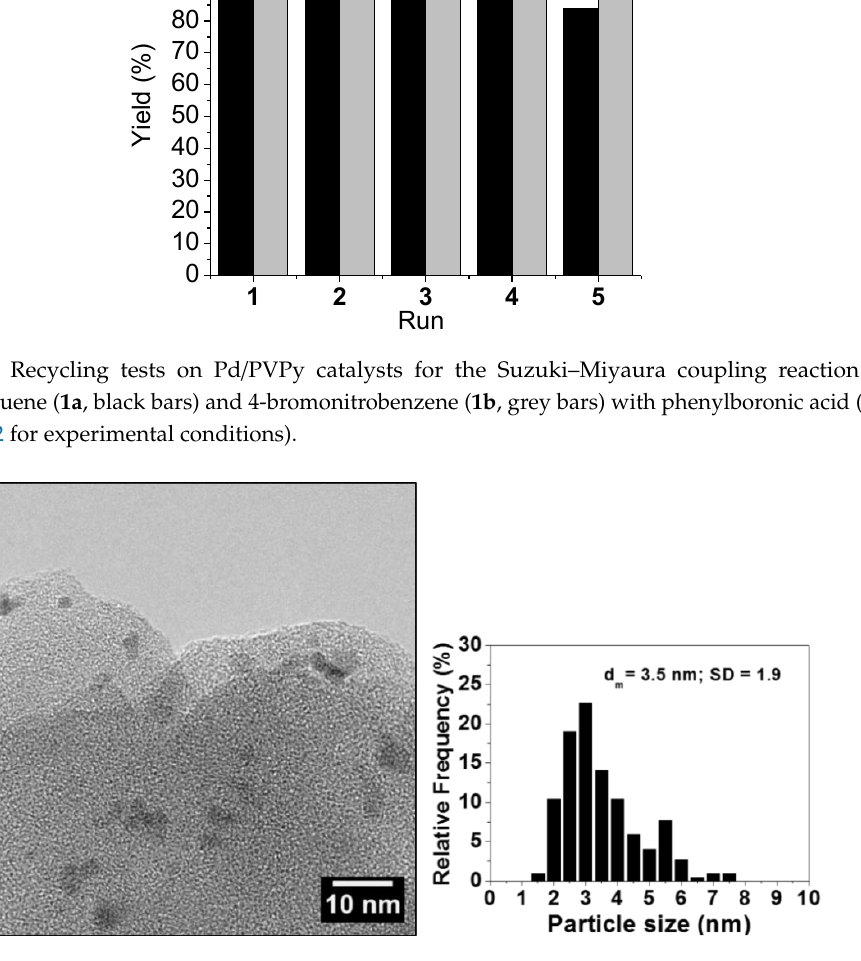
Figure 4 . Representative transmission electron microscopymicrograph and histogram of particle size distribution of Pd/PVPy system after the first catalytic cycle.